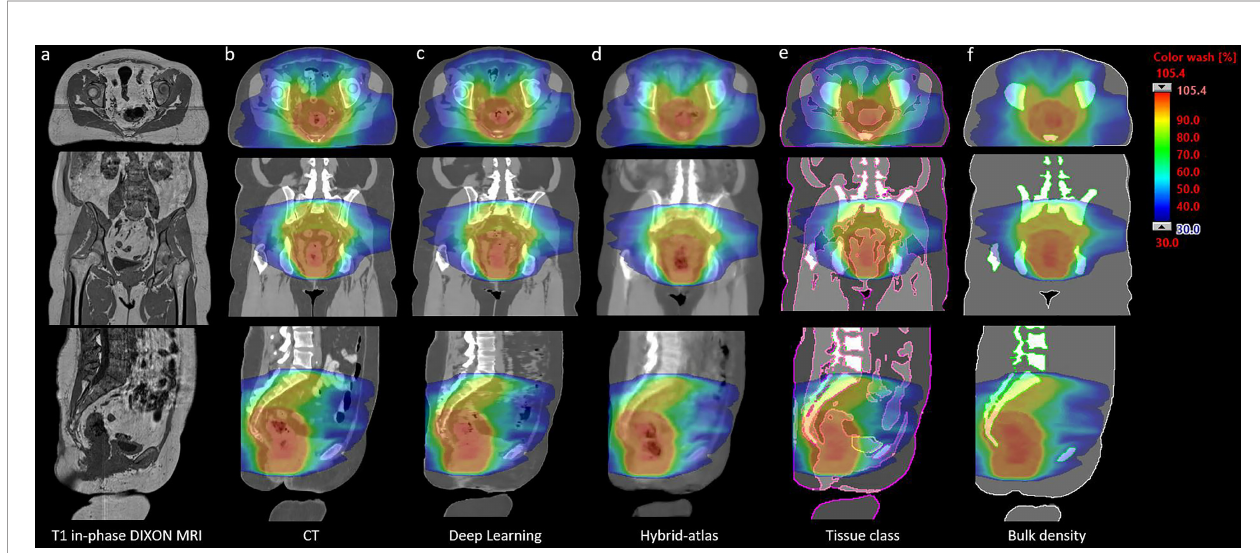
FIGURE 2 | CT and sCT scans (with corresponding MRI) with treatment plan calculated and dose color wash displayed. Column (A) T1 in-phase-stitched T1 VIBE Dixon; column (B) original CT scan column; column (C) deep learning-generated sCT; column (D) hybrid atlas-generated sCT; column (E) tissue class density assignment sCT (three tissue classes); and column (F) bulk density overrides